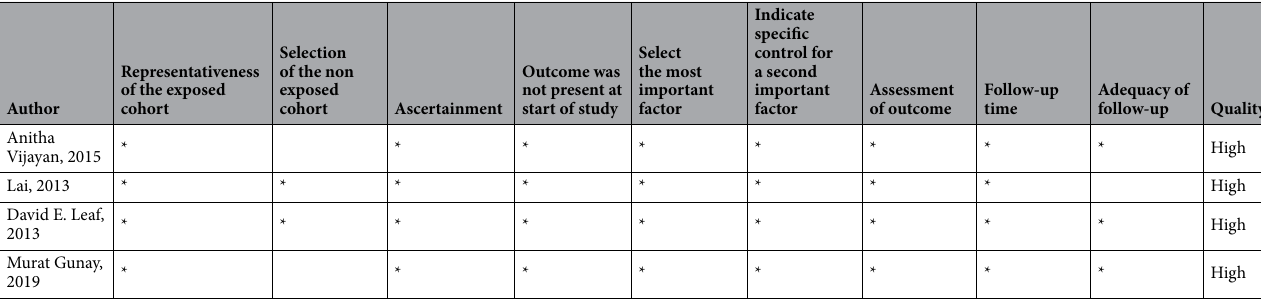
Table 1. Quality assessment of included studies (Newcastle–Ottawa Scale). *mean the article meets the entry of Newcastle-Ottawa Scale and gets 1